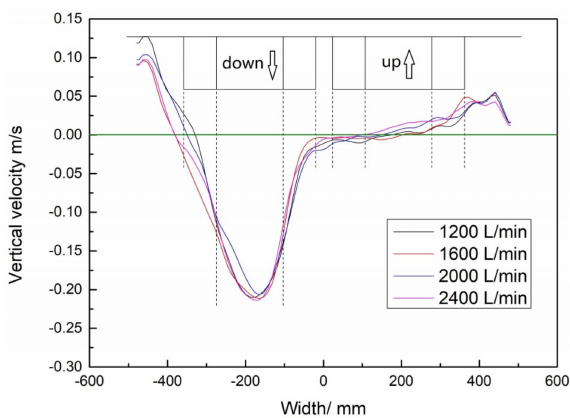
Figure 7. Vertical velocity distribution of flow field in mixing layer under di ff erent gas flow